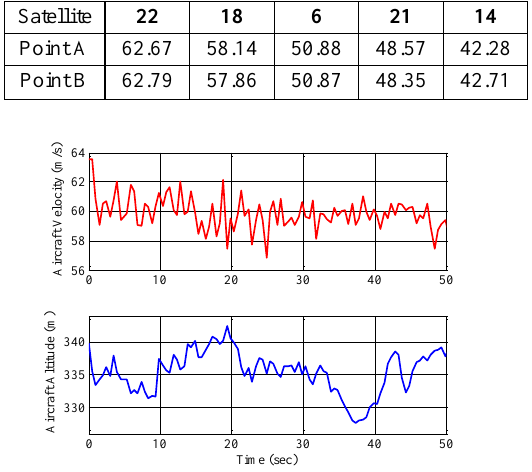
Figure 15. Aircraft altitude and speed over the duration of 50